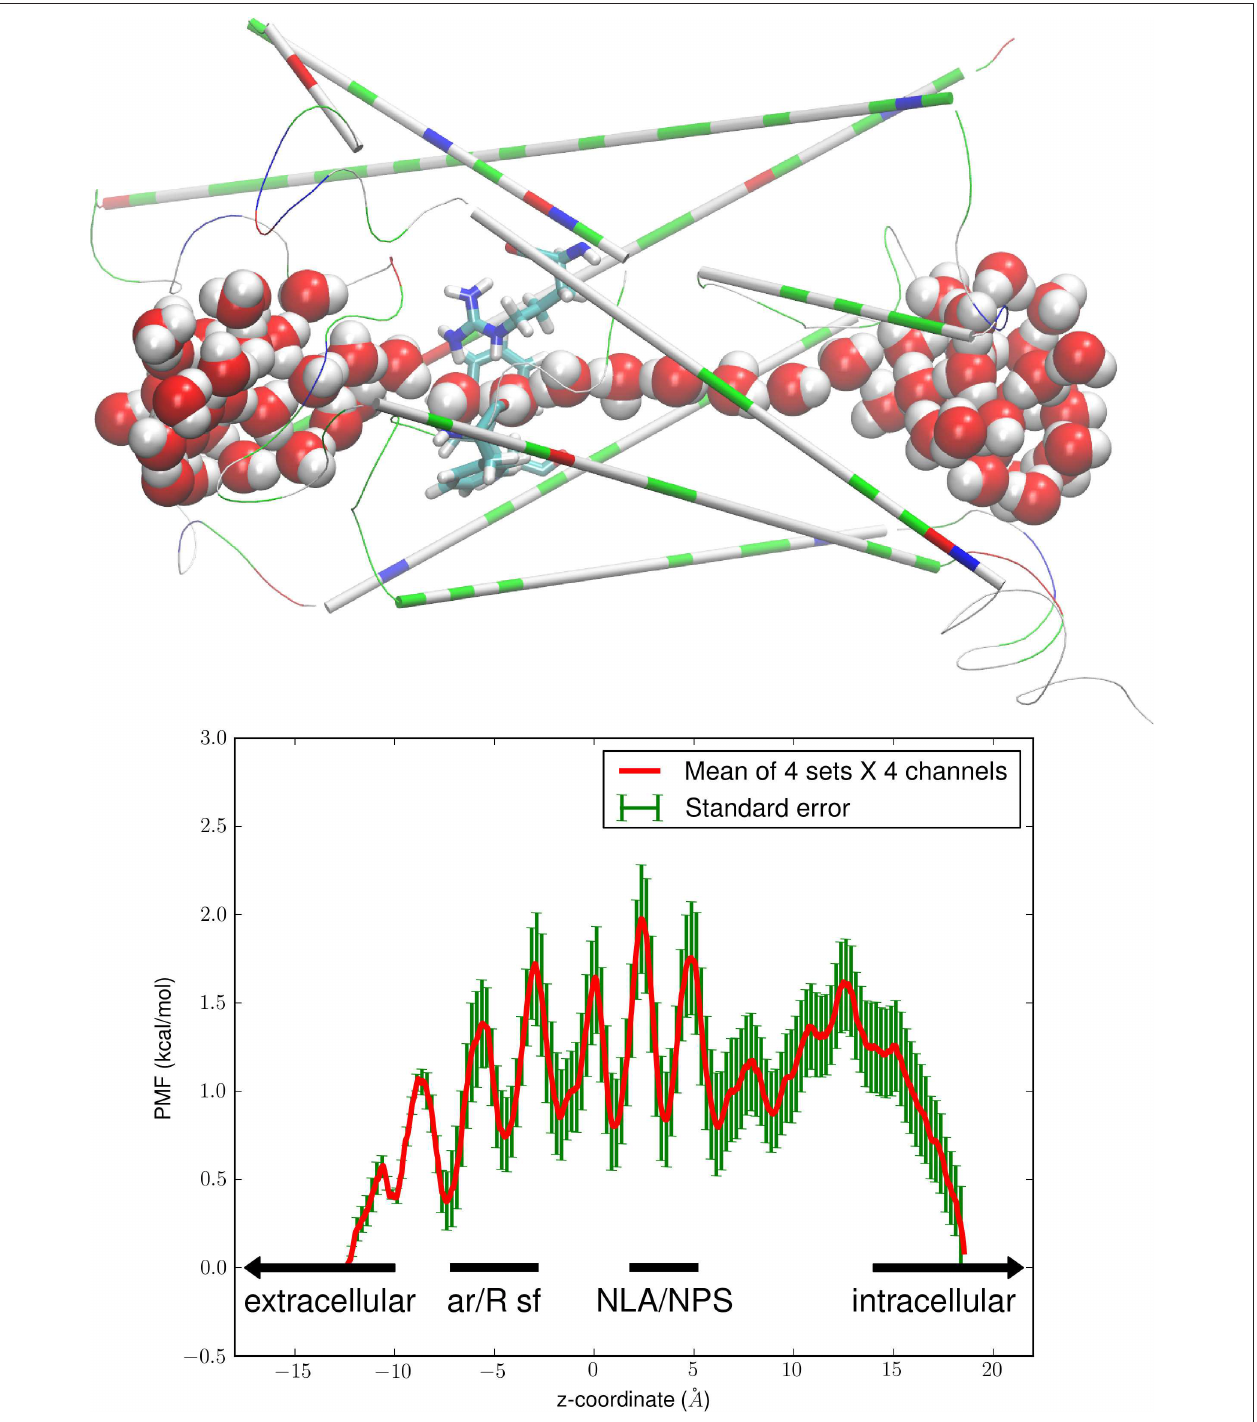
FIGURE 1 | Water-PbAQP interactions. The (Top panel) shows the single file of waters inside the PbAQP channel. The protein monomer (constituting one channel) is shown in thin cartoons colored by residue types (hydrophilic, green; hydrophobic, white; positively charged, blue; negatively charged, red). The ar/R selectivity filter residues (Arg 196, Phe 190, Trp 50) are shown in licorices colored by atoms (H, white; O, red; C, cyan; N, blue). Waters inside or near the channel are shown in large spheres colored by atoms. Graphics here and in the rest of the paper were rendered with VMD [46]. The (Bottom panel) shows the free-energy profile of water conduction through PbAQP. The PMF of water is plotted as a function of the z-coordinate along the channel axis of PbAQP. The ar/R SF and the NLA-NPS motifs regions are so marked. The mean values and the standard errors are over 16 sets of data (four sets of forward and reverse paths in each of the four channels of the PbAQP